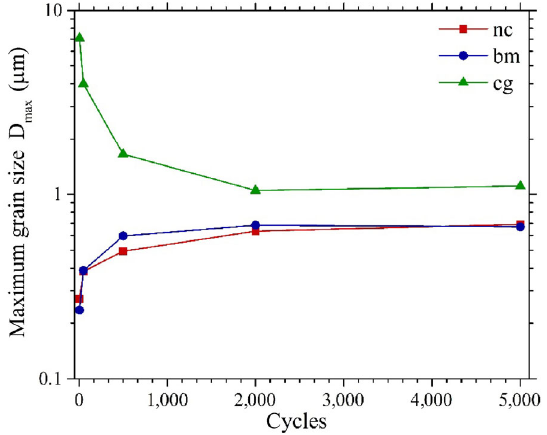
Fig. 10 Evolution of the maximum grain size D max over the cycle number for all three initial microstructures at 5